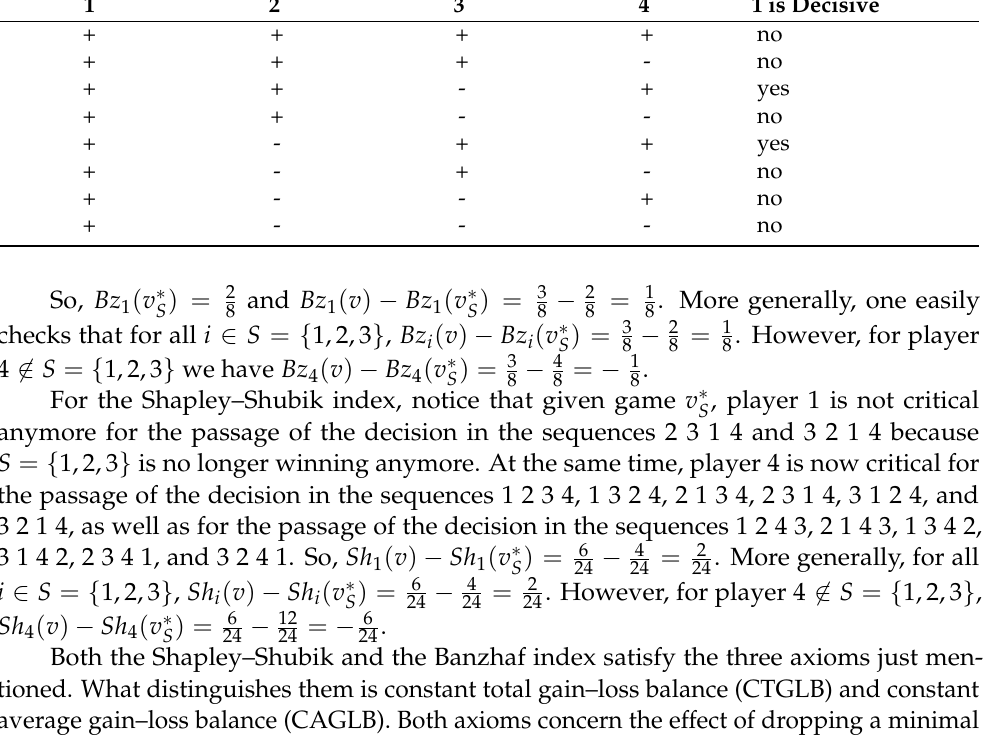
Table 2. Decisiveness of player 1 in game v ∗ with S = { 1,2,3 } . S 1 2 3 4 1 is Decisive + + + + no + + + - no + + - + yes + + - - no + - + + yes + - + - no + - - + no + - - -